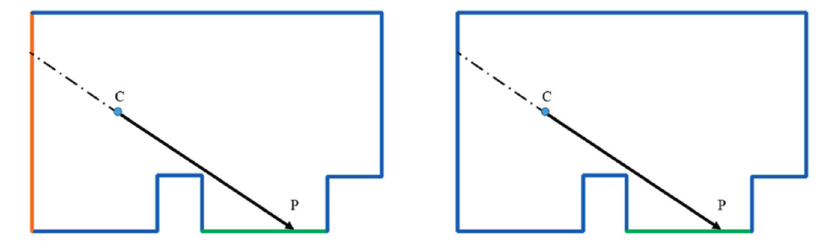
Figure 8. Schema of the CCW